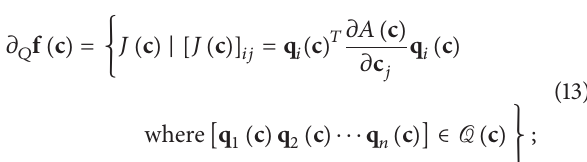
Algorithm 5 (the generalized inexact Newton method). (1) For 𝑘 = 0, 1, . . . until convergence, do the